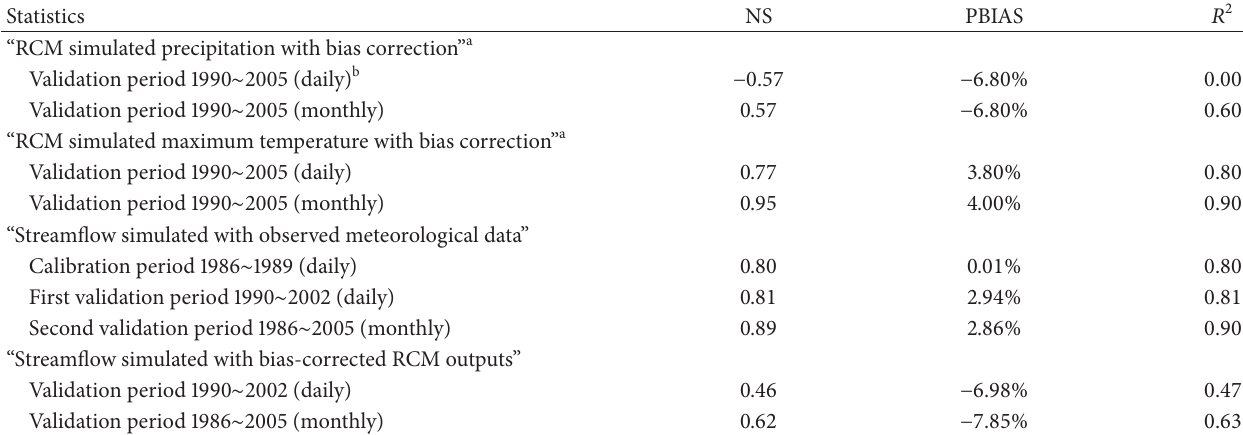
Table 2: Statistics of bias-corrected RCM outputs and SWAT simulated streamflows forced by the observed climate variables and bias- corrected RCM outputs.